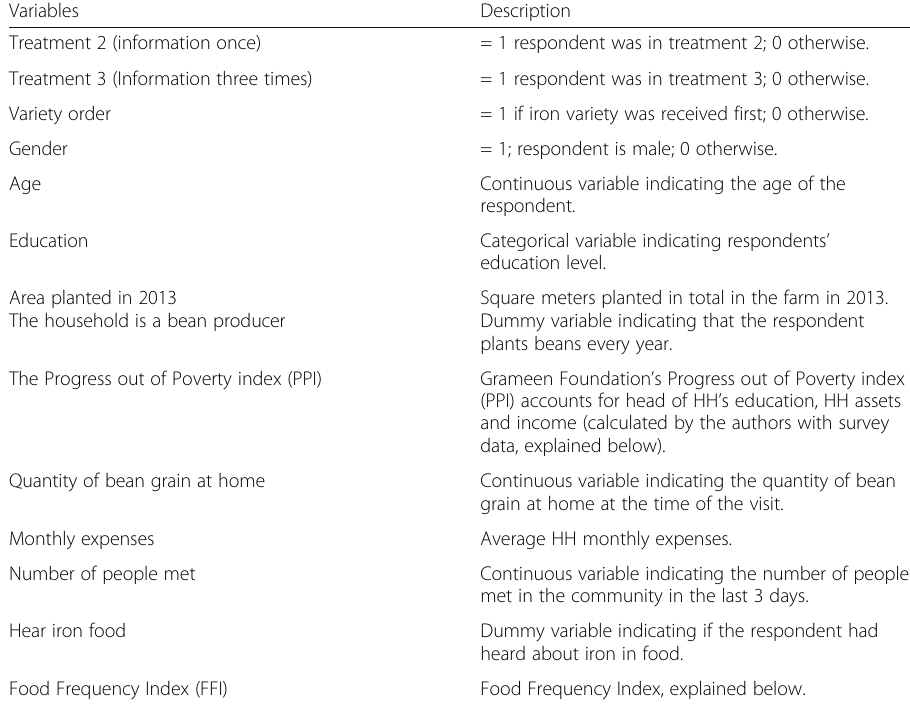
Table 1 Independent variables included in the models used Variables Description Treatment 2 (information once) Treatment 3 (Information three